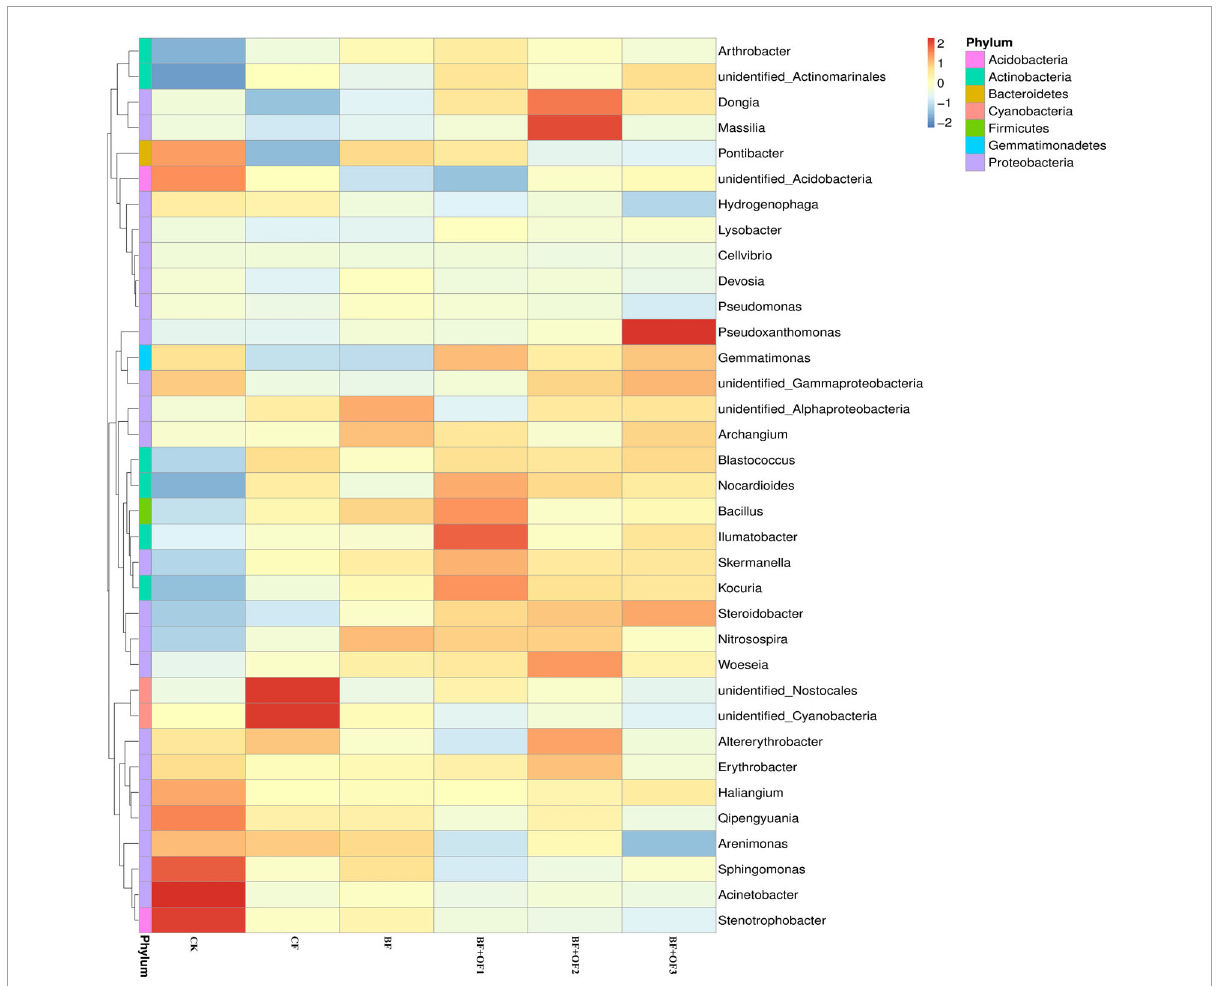
FIGURE6 Principal component analysis (PCA) of soil under different fertilization treatments based on the operational taxonomic unit (OTU) level. CK, no fertilizer, CF: chemical fertilizers (conventional dosage for this region); BF, balanced fertilizer (70% of total chemical fertilizer); BF + OF1, BF + OF2, and BF + OF3, balanced fertilizer plus 3,000, 6,000, and 12,000 kg.ha − 1 bio-organic fertilizer,